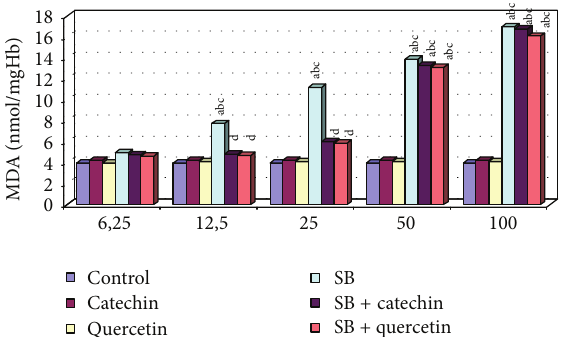
Figure 4: GPx activity in erytrocytes of control and experimental groups. Different letters above the bars indicate significant differ- ences between exposure concentrations; bars with the same letter are not significantly different. Values are mean ± SD in each group. Significance at 𝑃 < 0.05 .